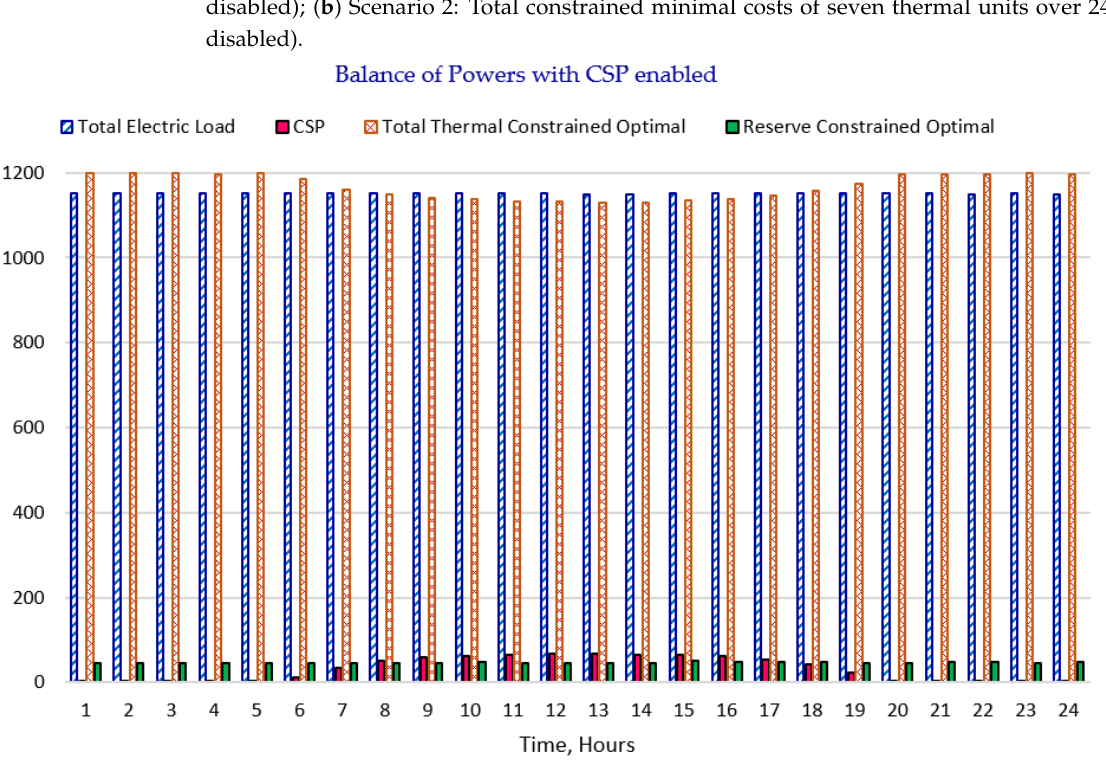
Figure 9. Balance of powers in Scenario 1 (hybrid system with CSP enabled) and Scenario 2 (thermal system with CSP disabled), during 24 h.